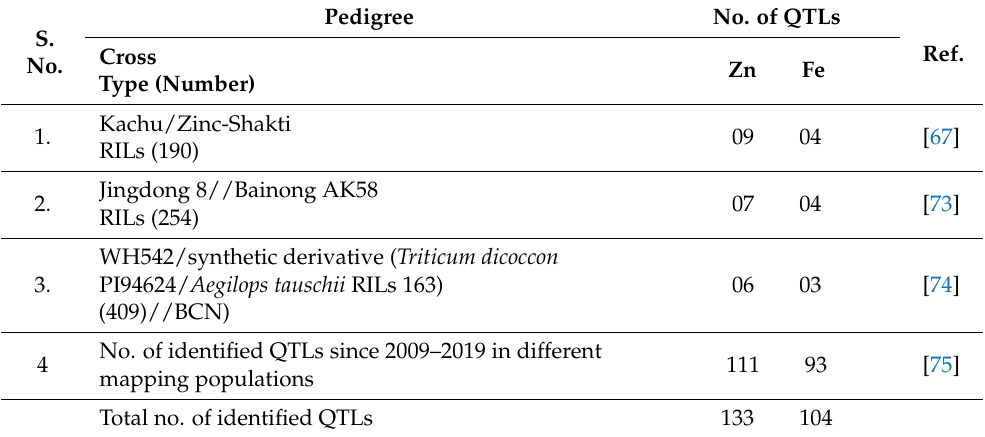
Table 2. Identified QTLs for grain Zn and concentration in different mapping populations in bread wheat ( Triticum aestivim .